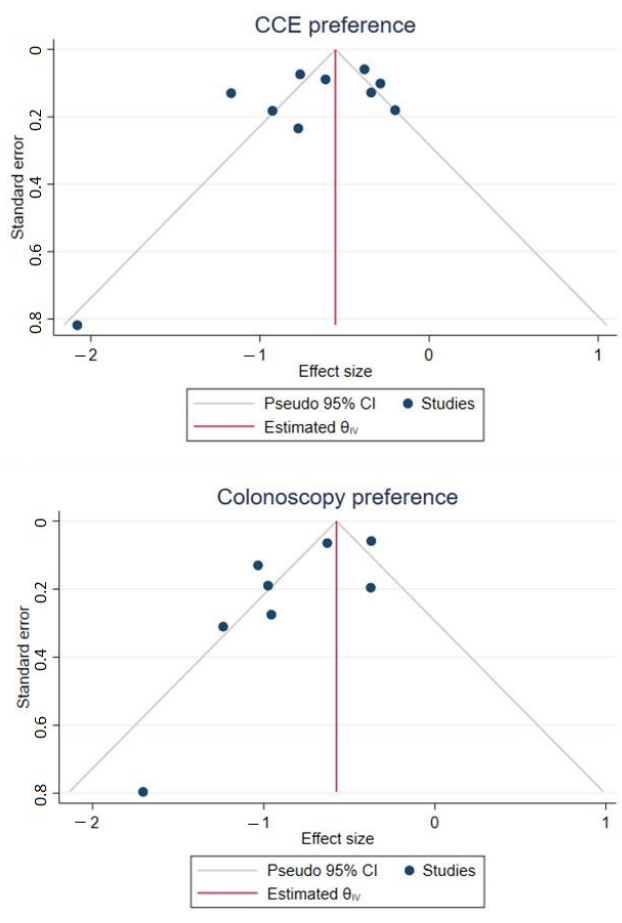
Figure 4. Funnel